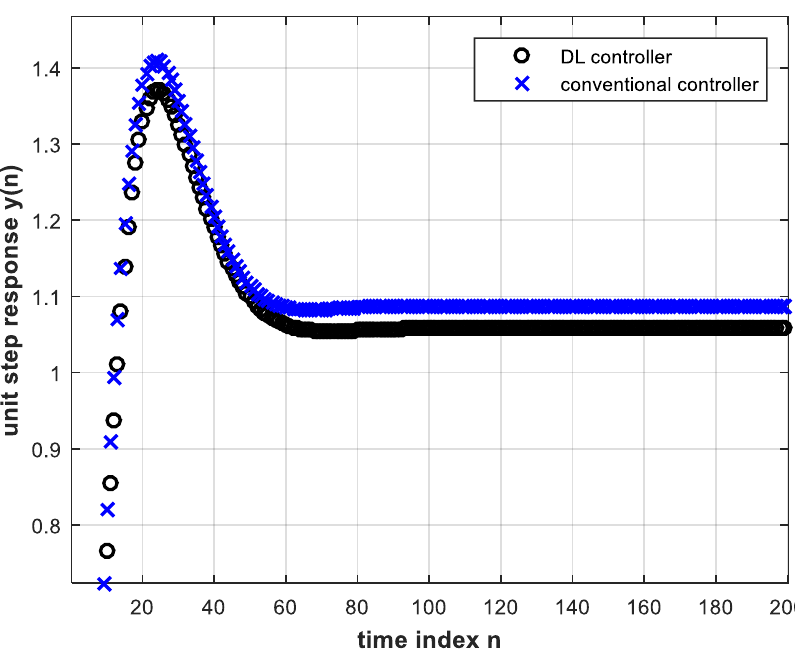
Figure 13. A magnified view of Figure